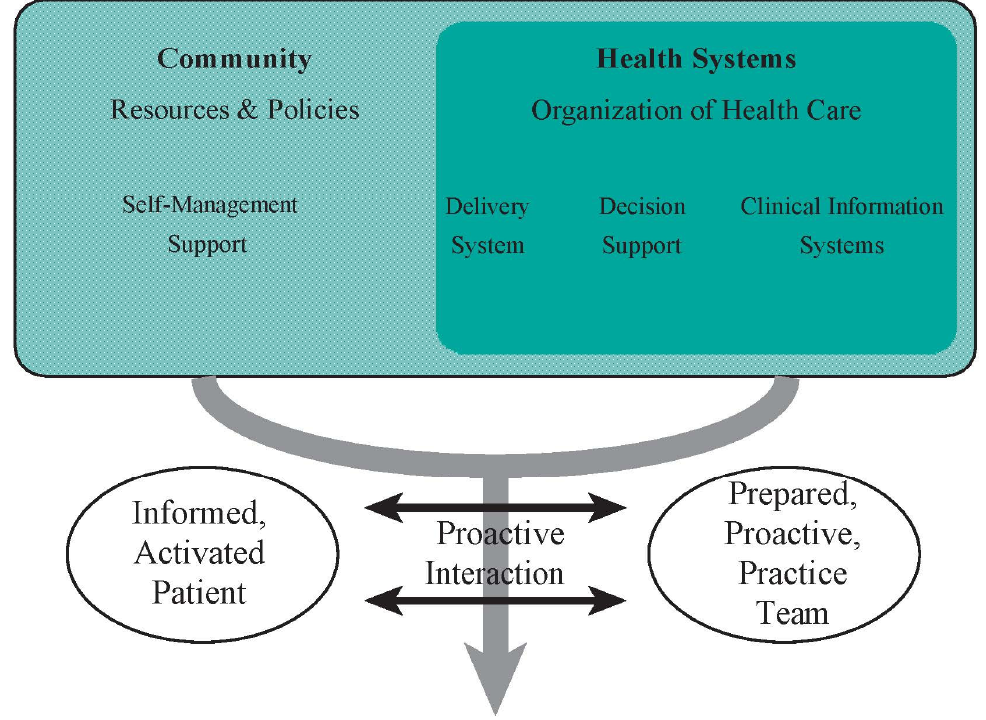
Figure 1. The Chronic Care Model (CCM)—community and professional engagement.